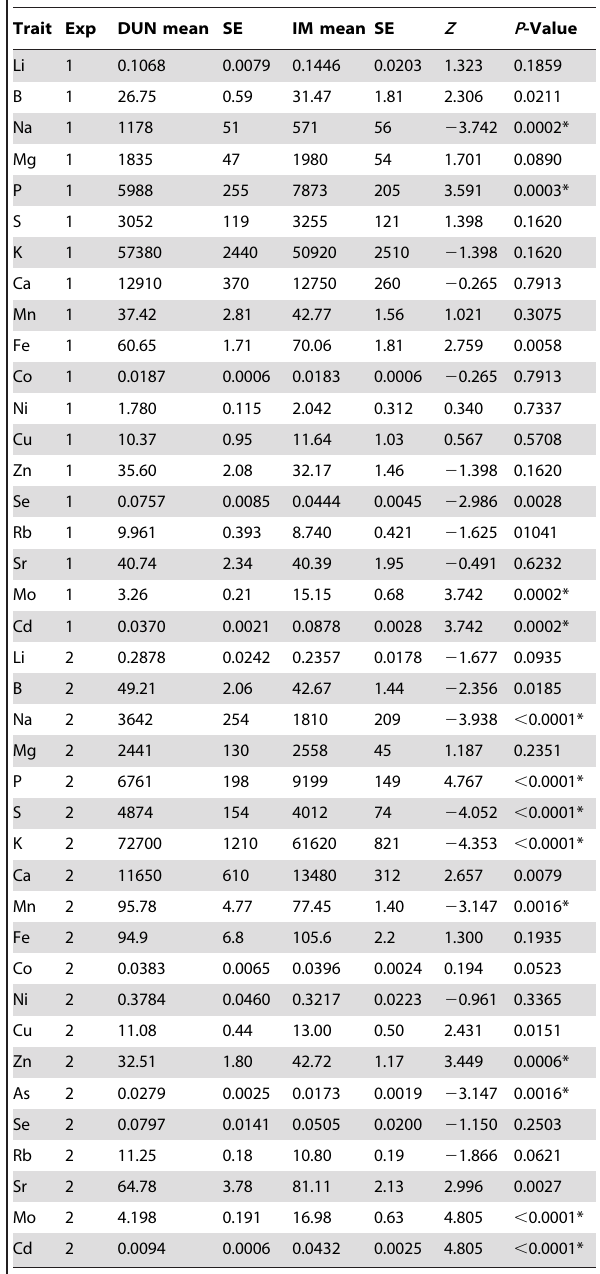
Table 1. Parental means for elemental accumulation ( m g g 2 1 ) in both experiments, and comparison by Wilcoxon Rank-Sum